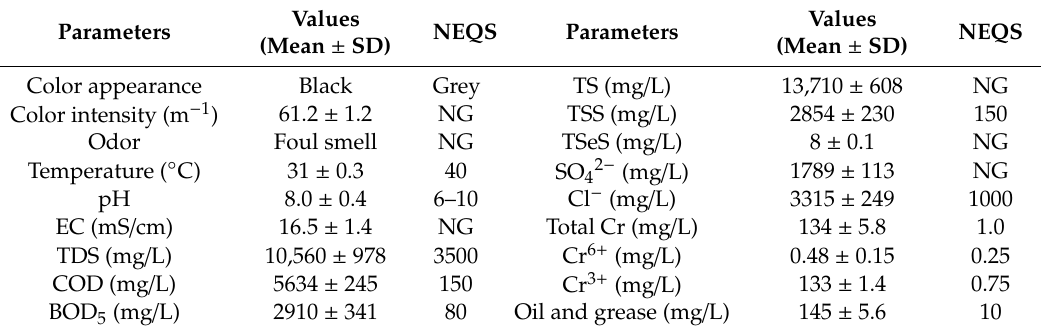
Table 1. Physical–chemical characteristics of tannery e ffl